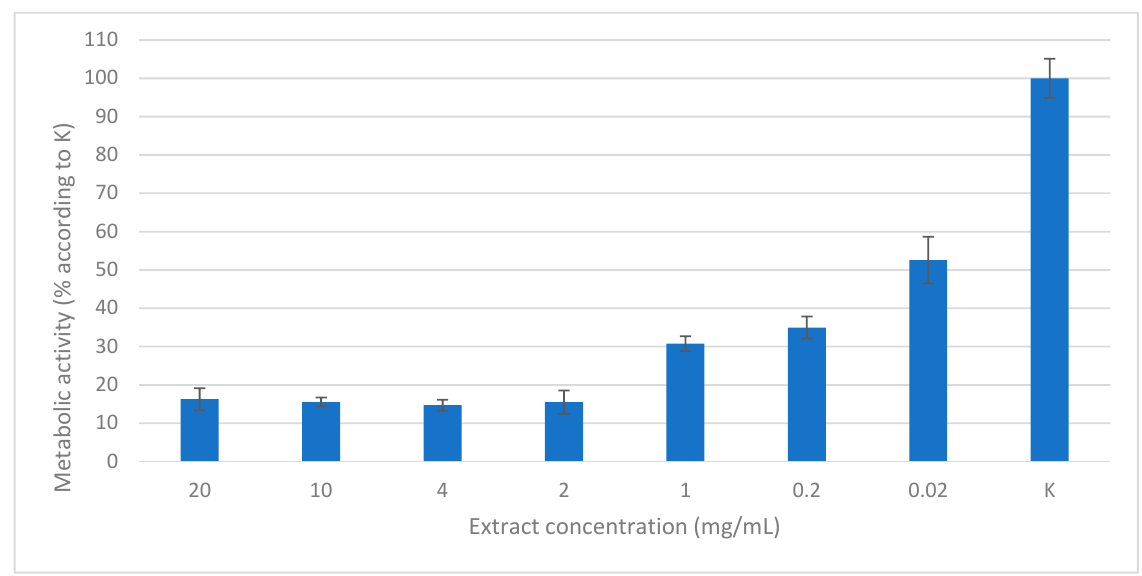
Figure 5. Inhibitory effect of extract A on the metabolic activity on human melanoma cells WM 266 4 as a function of extract concentration.